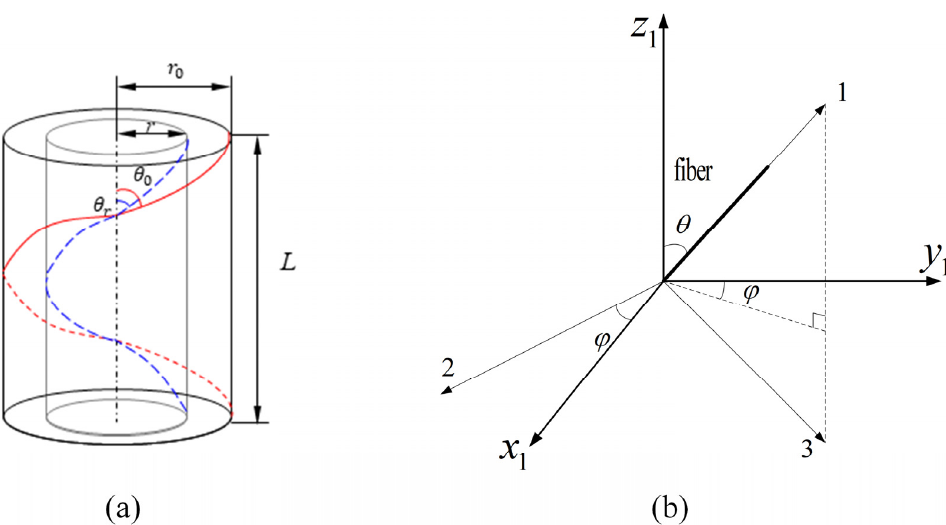
Figure 3. De fi nitions of the fi ber orientation angles. ( a ) The twisting angle of fi ber from inner Figure 3. Definitions of the fiber orientation angles. ( a ) The twisting angle of fiber from inner periphery to outer periphery in the yarn; ( b )The relation between the fi ber orientation with the RVE1 periphery to outer periphery in the yarn; ( b ) The relation between the fiber orientation with the RVE1 coordinate system. coordinate